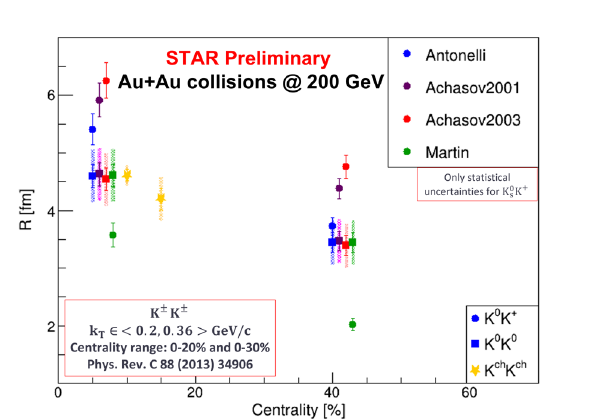
K 0 K ± source at √ s NN = 200 , and K 0 S S S